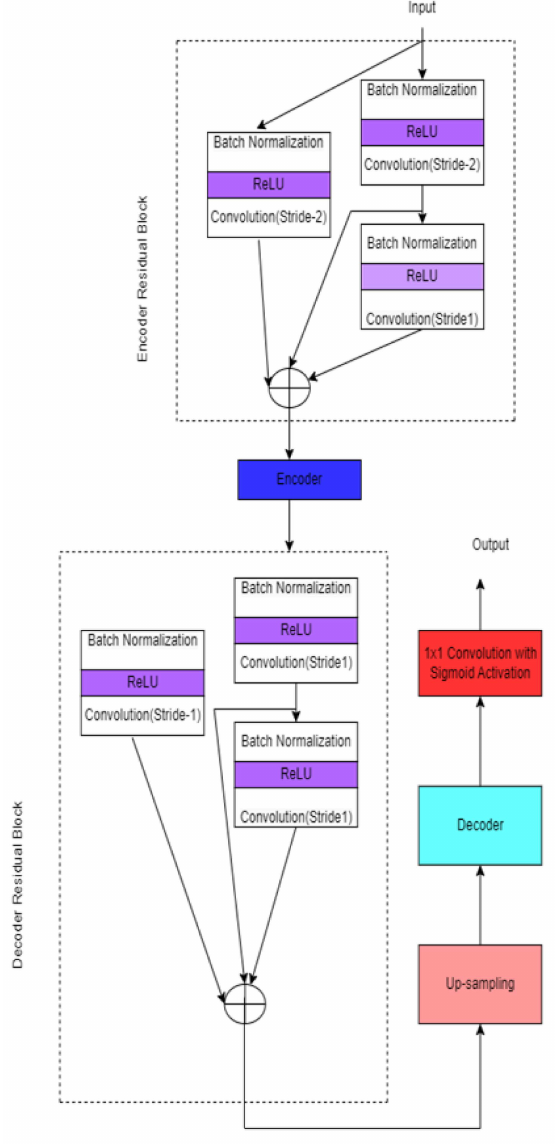
Figure 16. Res-D-UNET. A ReLU activation layer, a batch normalization layer, and two convolution layers with strides of 2 and 1 are included in each convolution block. In addition, a